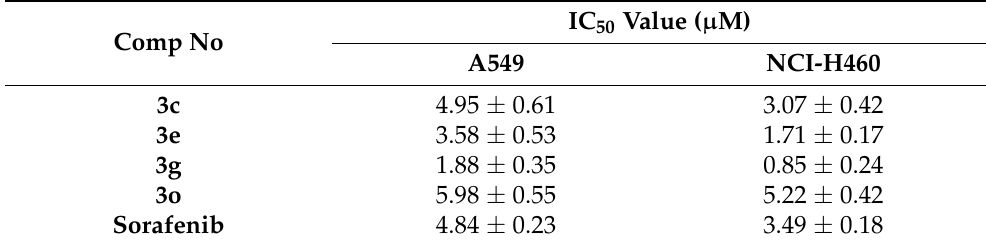
Table 1. Cytotoxicity screening of the tested benzimidazole molecules 3c , 3e , 3g , and 3o against A549 and NCI-H460 lung cancer cell lines. Data expressed as the mean ± SD.